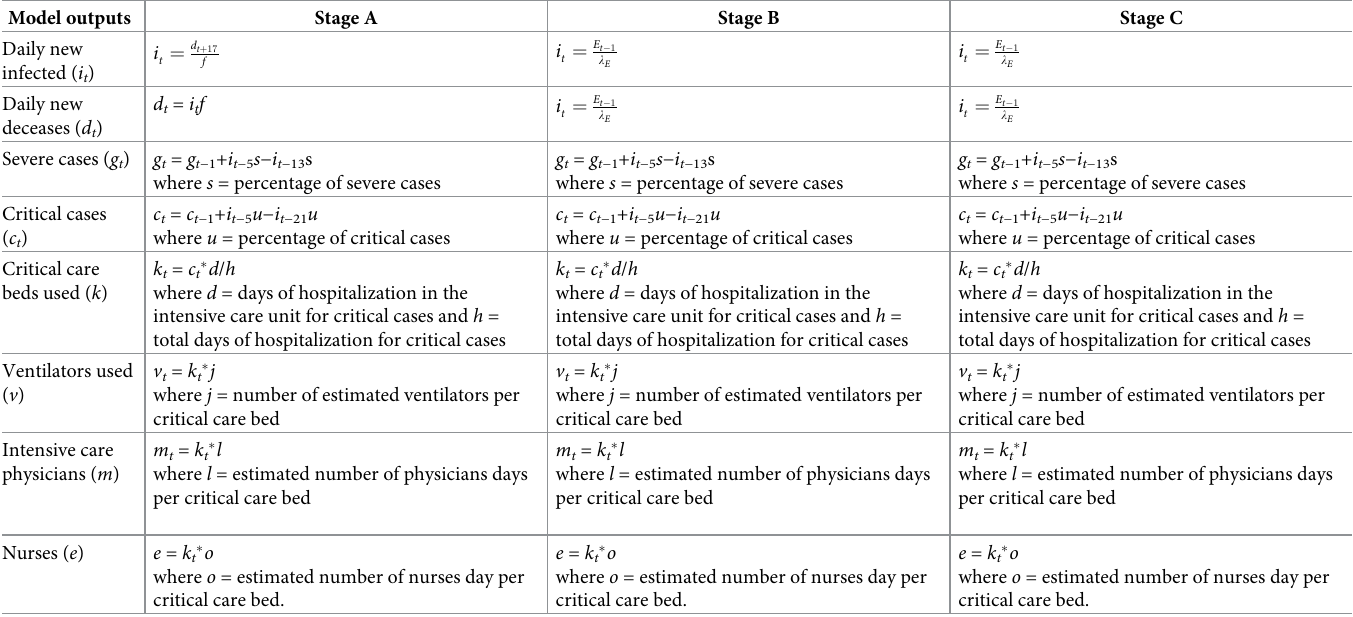
Table 1. Equations for the main model outputs in different stages. Model outputs Stage A Stage B